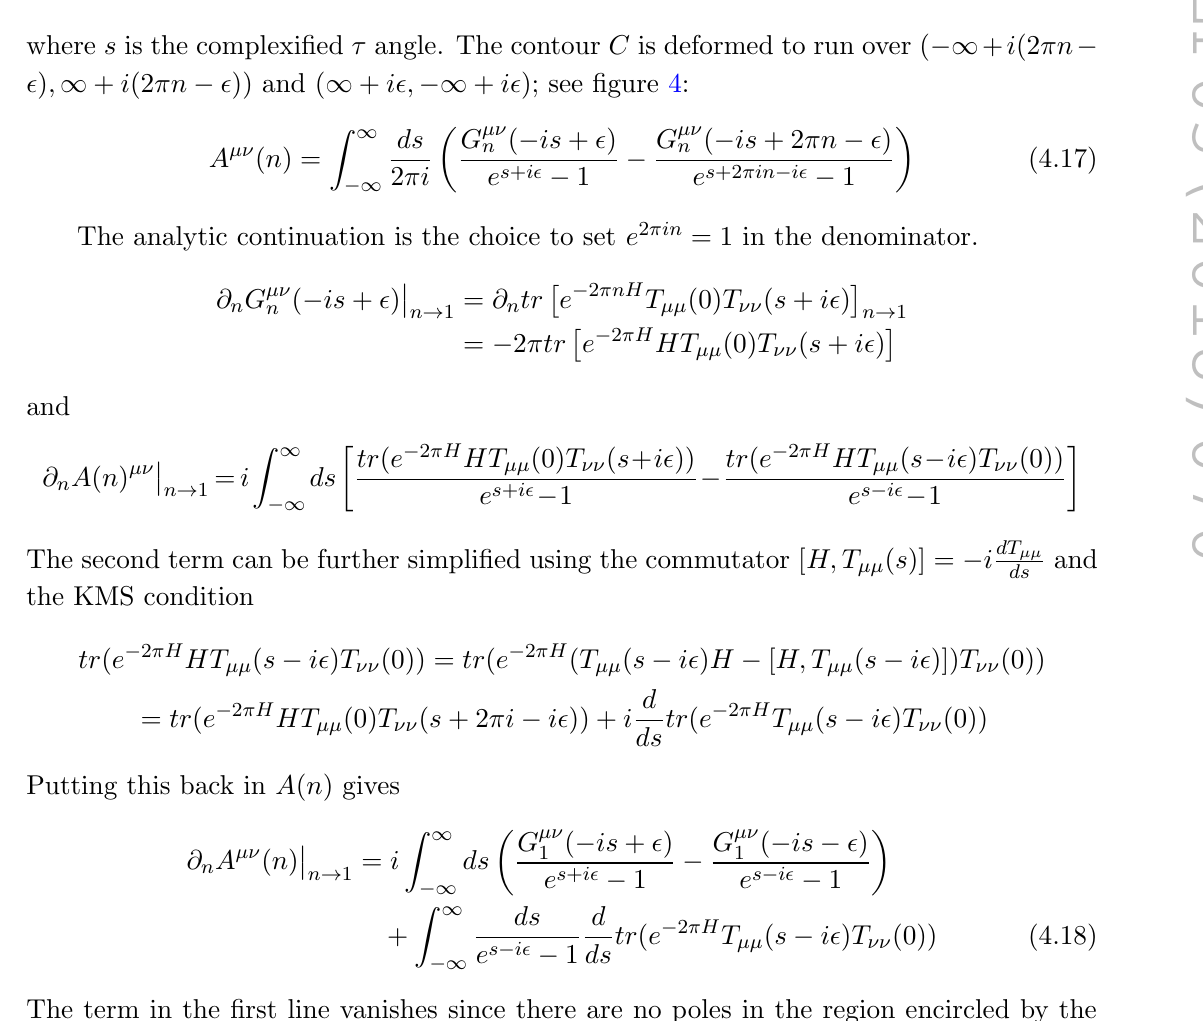
+ i (2 (cid:25)n (cid:15) ) ; + i (2 (cid:25)n (cid:15) )) and ( + i(cid:15); + i(cid:15) ). (cid:0)1 (cid:0) 1 (cid:0) 1 (cid:0)1 + i (2 (cid:25)n (cid:0)1